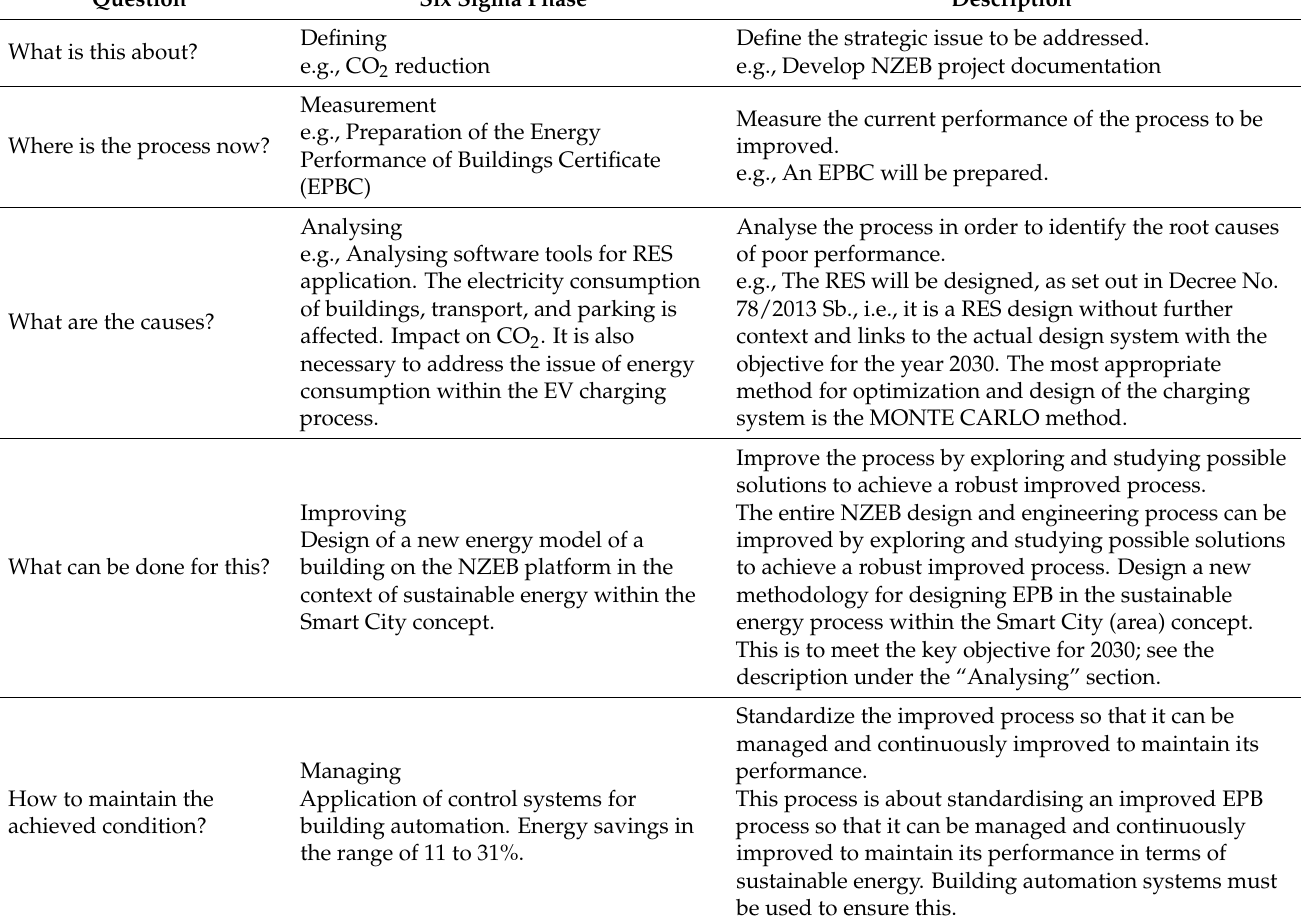
Table 3. Six Sigma principles. Example of a solution in our